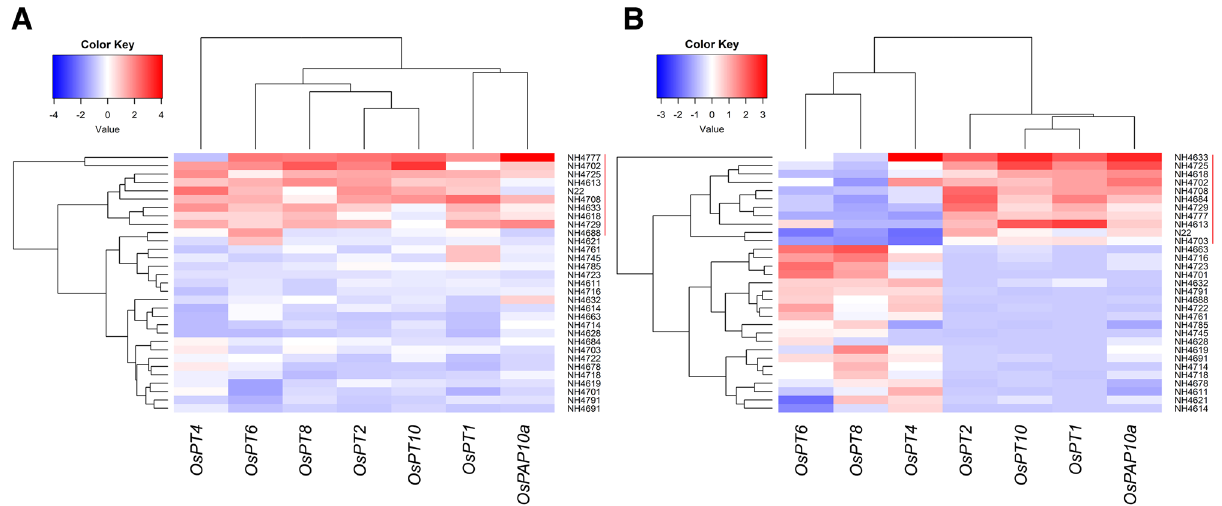
Figure 18. Heatmaps of relative expression levels of the genes involved in the P uptake and transport. Expression of these genes in seedlings obtained from germination of seeds harvested from low P plot was compared with the seedlings obtained from germination of seeds harvested from normal P plot. ( A ) Relative expression levels of genes in roots of 12 days old seedlings. ( B ) Relative expression levels of genes in roots of 24 days old seedlings. LGPS mutants and WT are shown by red bar.